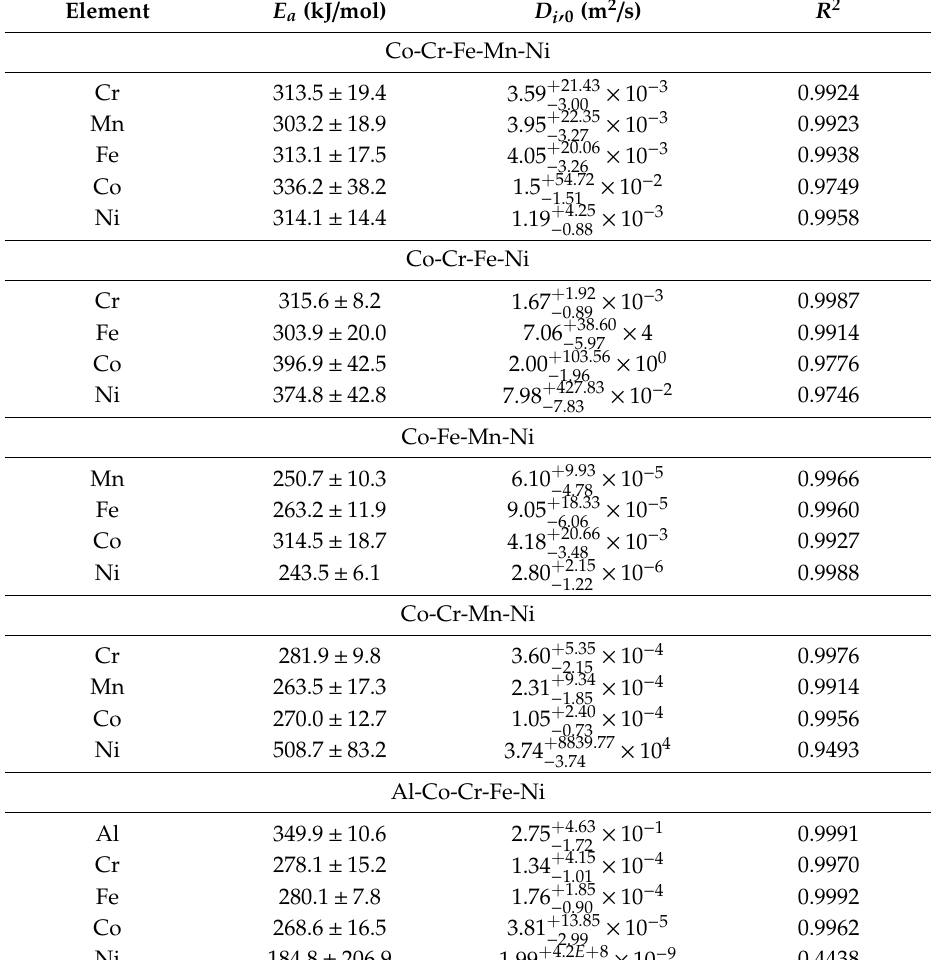
Table9. Valuesofenergiesofactivation E a , pre-exponentialfactors D i, 0 , andcoe ffi cientsofdetermination R 2 , obtained as a result of fitting the results with the Arrhenius relation